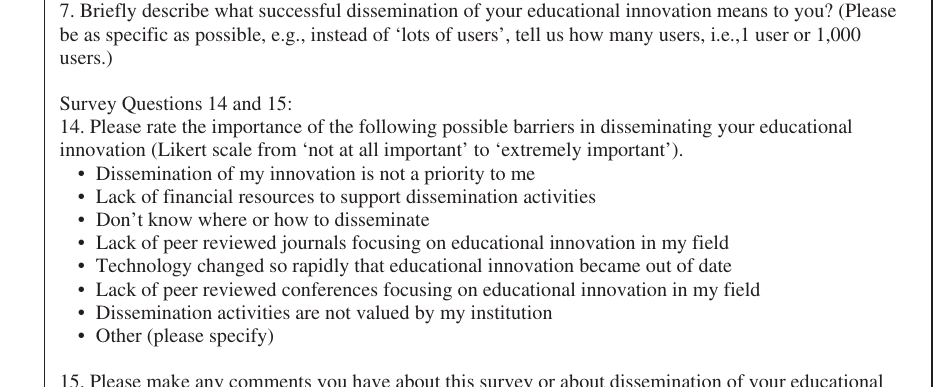
FIG. 3. Survey questions analyzed, adapted from Khatri et al. 2012